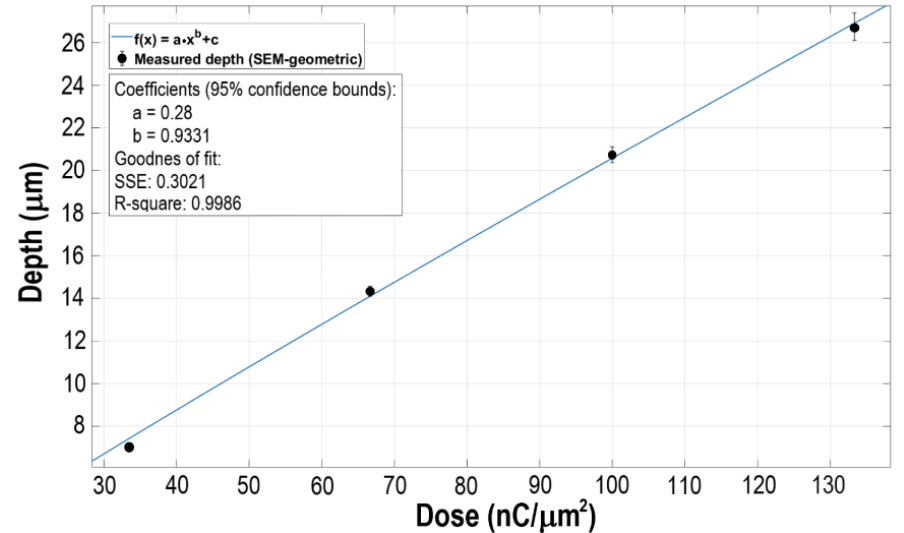
Figure 2. Depth calibration curve as a function of impinging ion dose, for a set of circular wells milled by FIB on T91 steel with acceleration voltage V a = 30 keV and ion spot current I = 9.3 nA. Three wells are averaged per ion dose.